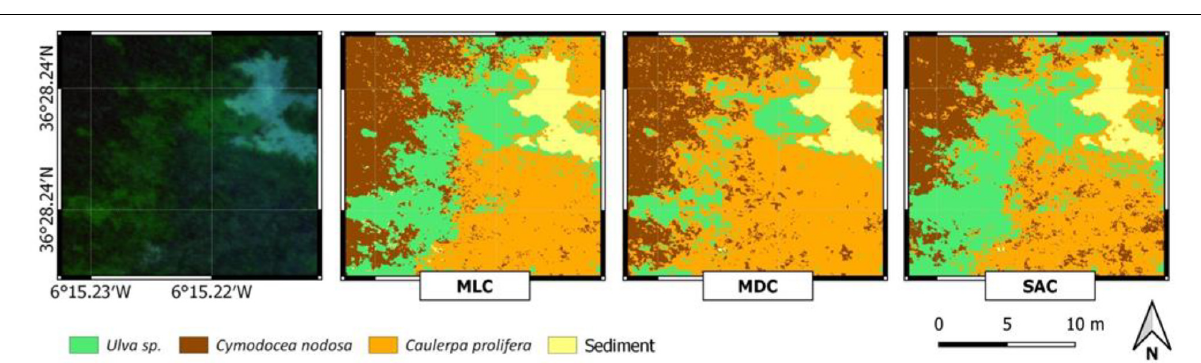
FIGURE 7 | Spectral angle classifier, trained using image-derived spectra, result from the multispectral UAV survey in the study area. Coordinates are in WGS84 (EPSG: 4326).